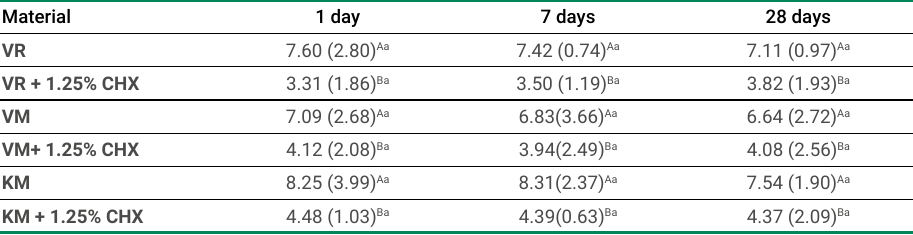
Table 3. Comparison of means (standard deviations) in MPa of diametral tensile strength for the glass ionomer cements containing or not 1.25% CHX at different storage times. Material